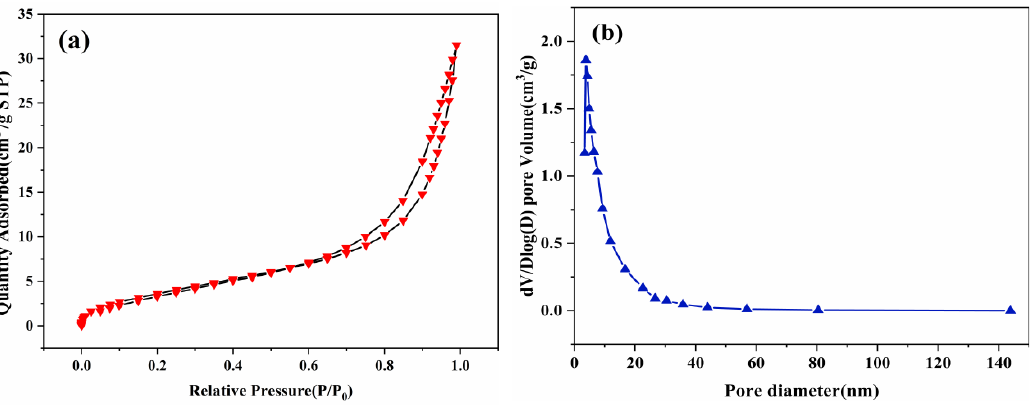
Figure 6. BET analysis of PNMBC (TOCN – PEI:MB = 1:1): ( a ) N 2 adsorption – desorption curves and